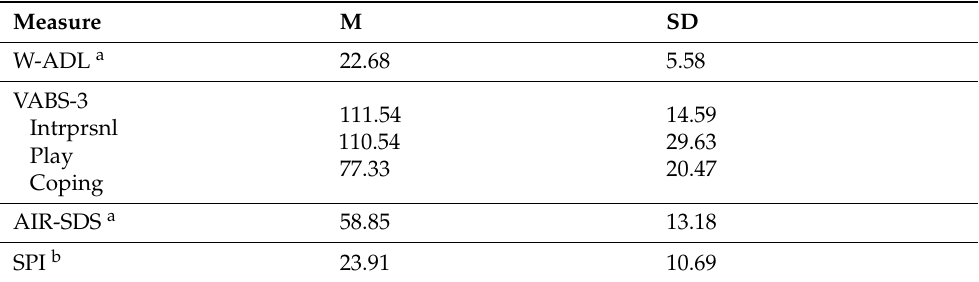
Table 3. Means and Standard Deviation for Measures of Independent